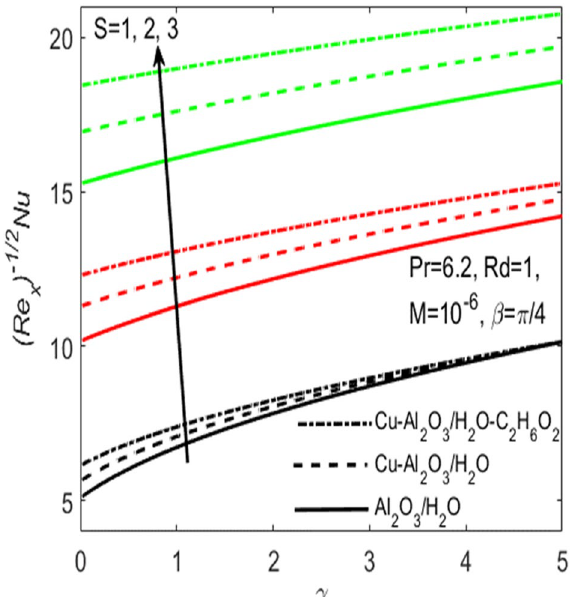
Figure 12. Influence of S on Nu for different hybrid nanofluids and simple nanofluid.